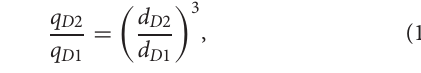
two main coronary arteries (LAD and LCx) were